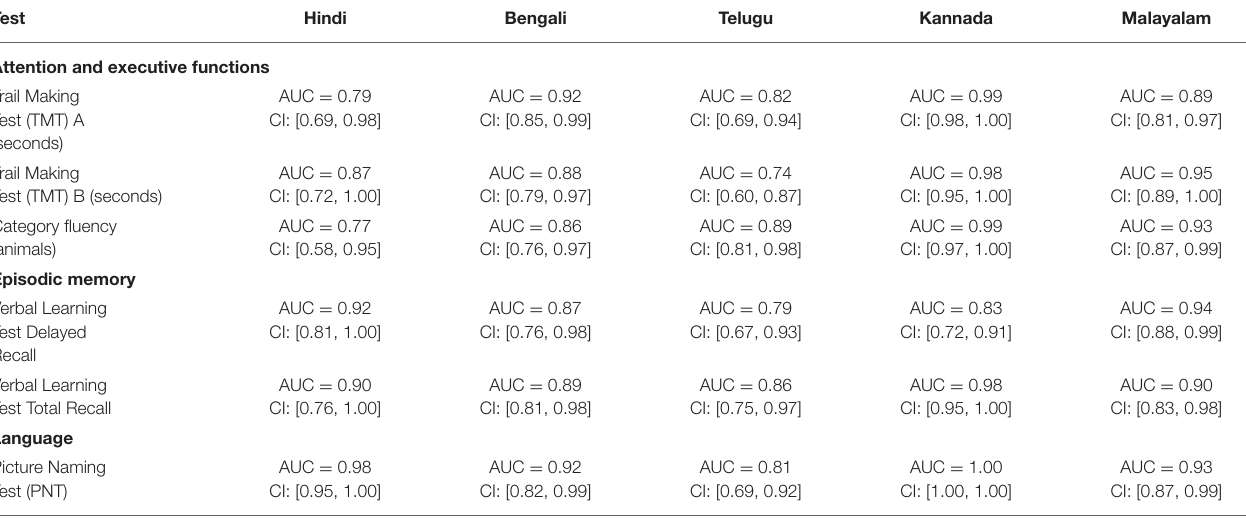
TABLE 3 | Area under curves of ICMR-NCTB tests across five languages.